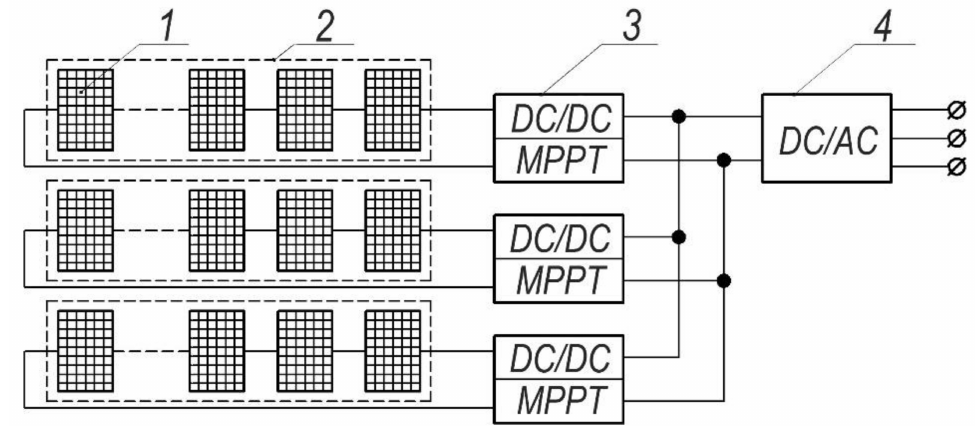
Figure 9. Block diagram of differentiated maximum power take-off systems (1—module; 2—array of modules; 3—voltage stabilizers with MPPT;